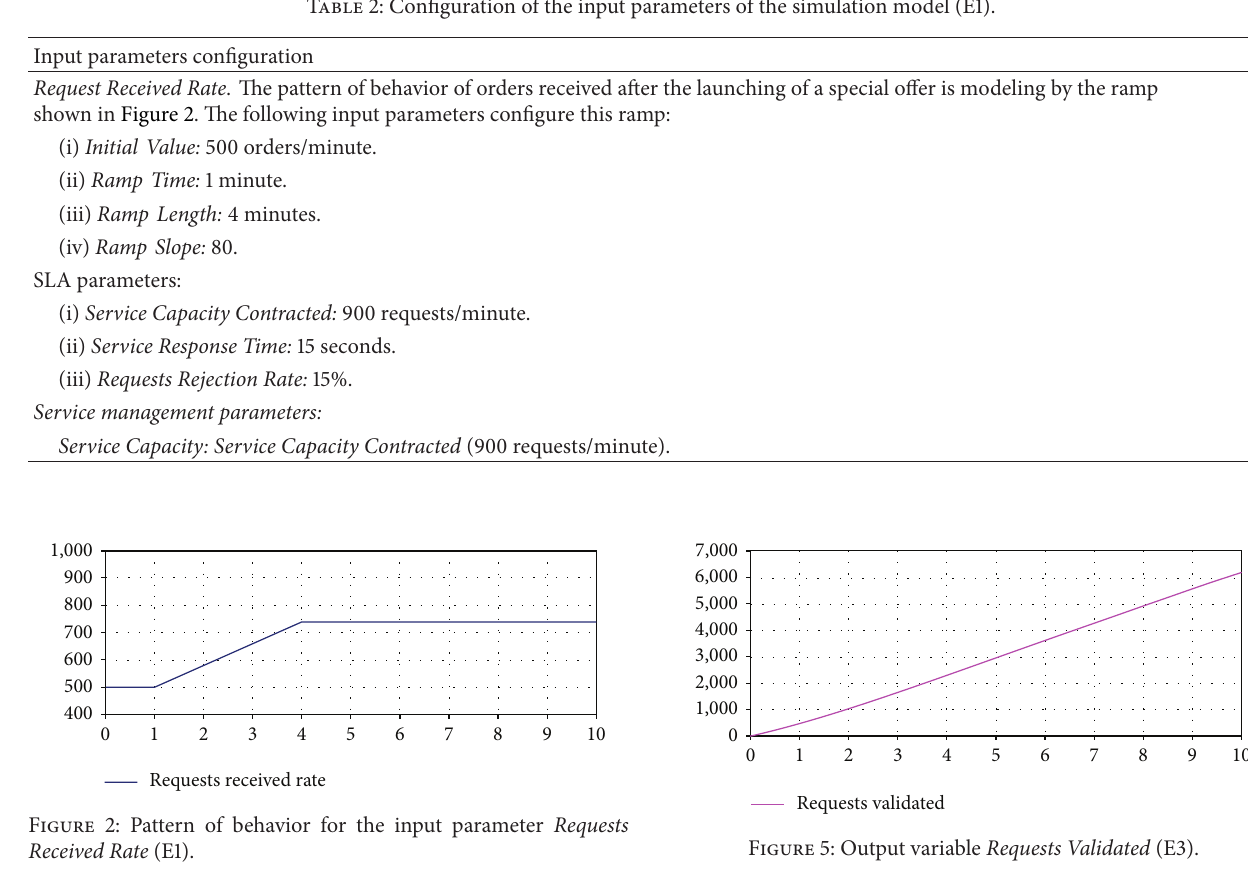
Table 2: Configuration of the input parameters of the simulation model (E1).